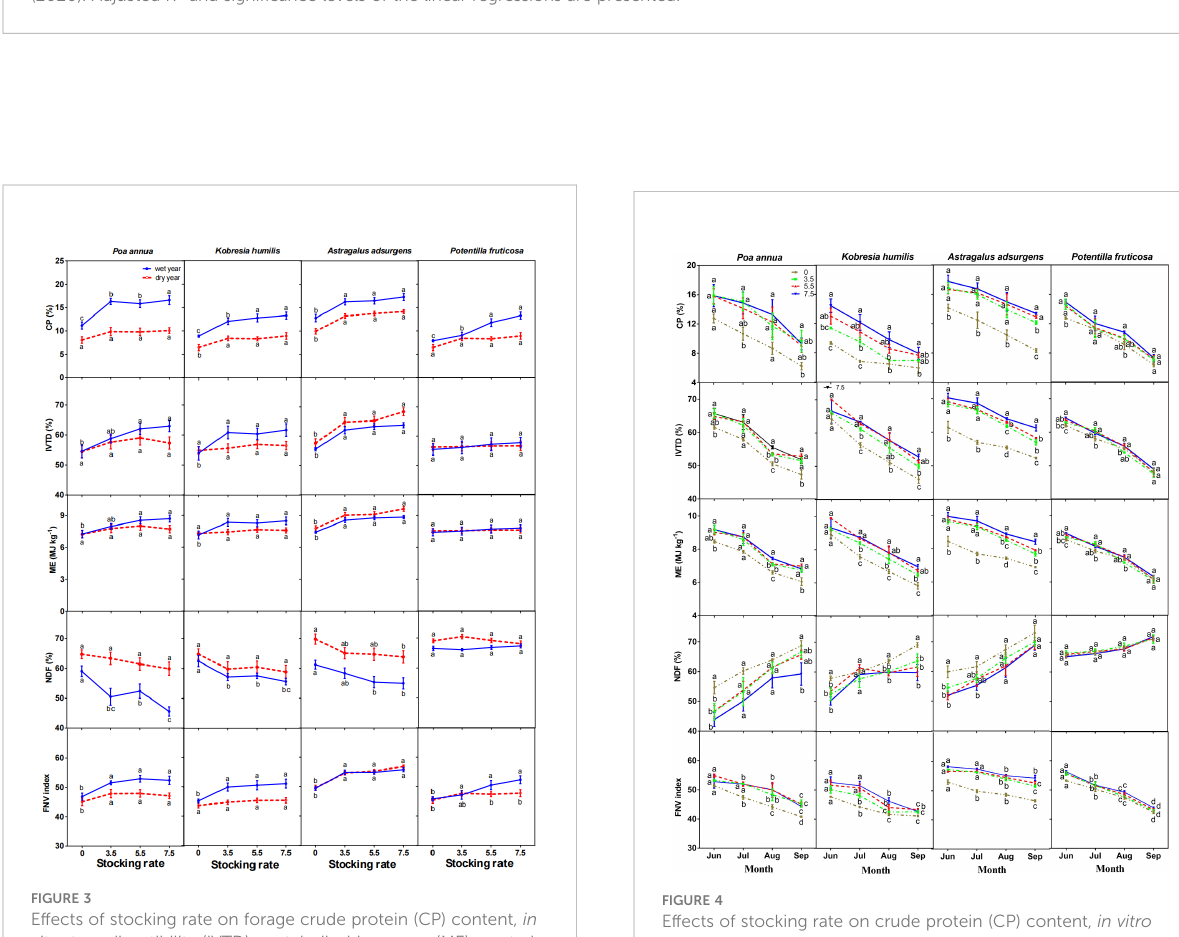
FIGURE 3 Effects of stocking rate on forage crude protein (CP) content, in vitro true digestibility (IVTD), metabolizable energy (ME), neutral detergent fi ber (NDF) content and forage nutritional value (FNV) of four dominant species in a wet year (2019) and a dry year (2020) (mean ± standard error). Bars with different letters in the same year differ from each other ( P< 0.05).